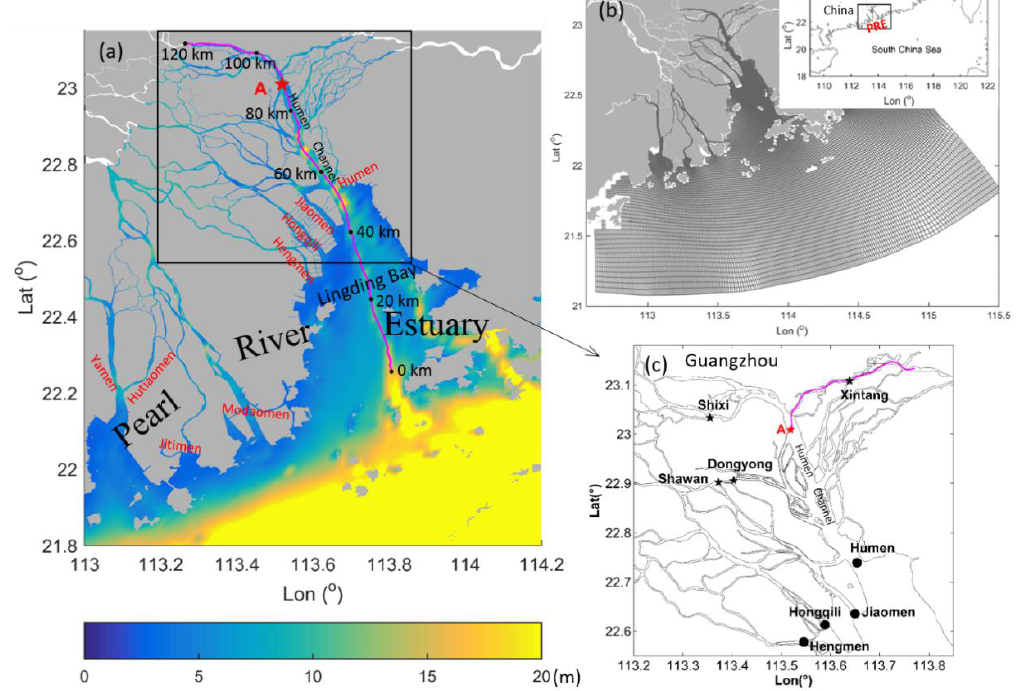
Figure 1. ( a ) Bathymetry of Pearl River Estuary (PRE), which includes eight outlets (Humen, Jiaomen, Hongqili, Hengmen, Modaomen, Jitimen, Hutiaomen, and Yamen). The Humen Channel connects the upper tributaries to the downstream estuary (Lingding Bay). The transect along the main channel of the estuary is approximately 120 km from the mouth to the head. The red pentangle in the Humen Channel indicates the location of station A for later analyses. ( b ) Model grids covering the entire PRE and adjacent shelf water of the northern South China Sea. ( c ) Locations of drinking-water intake stations for the four waterworks (Xintang, Shixi, Dongyong, and Shawan) in the upper tributaries of the PRE. The transect along the tributary where Xintang is located is used for later analyses.